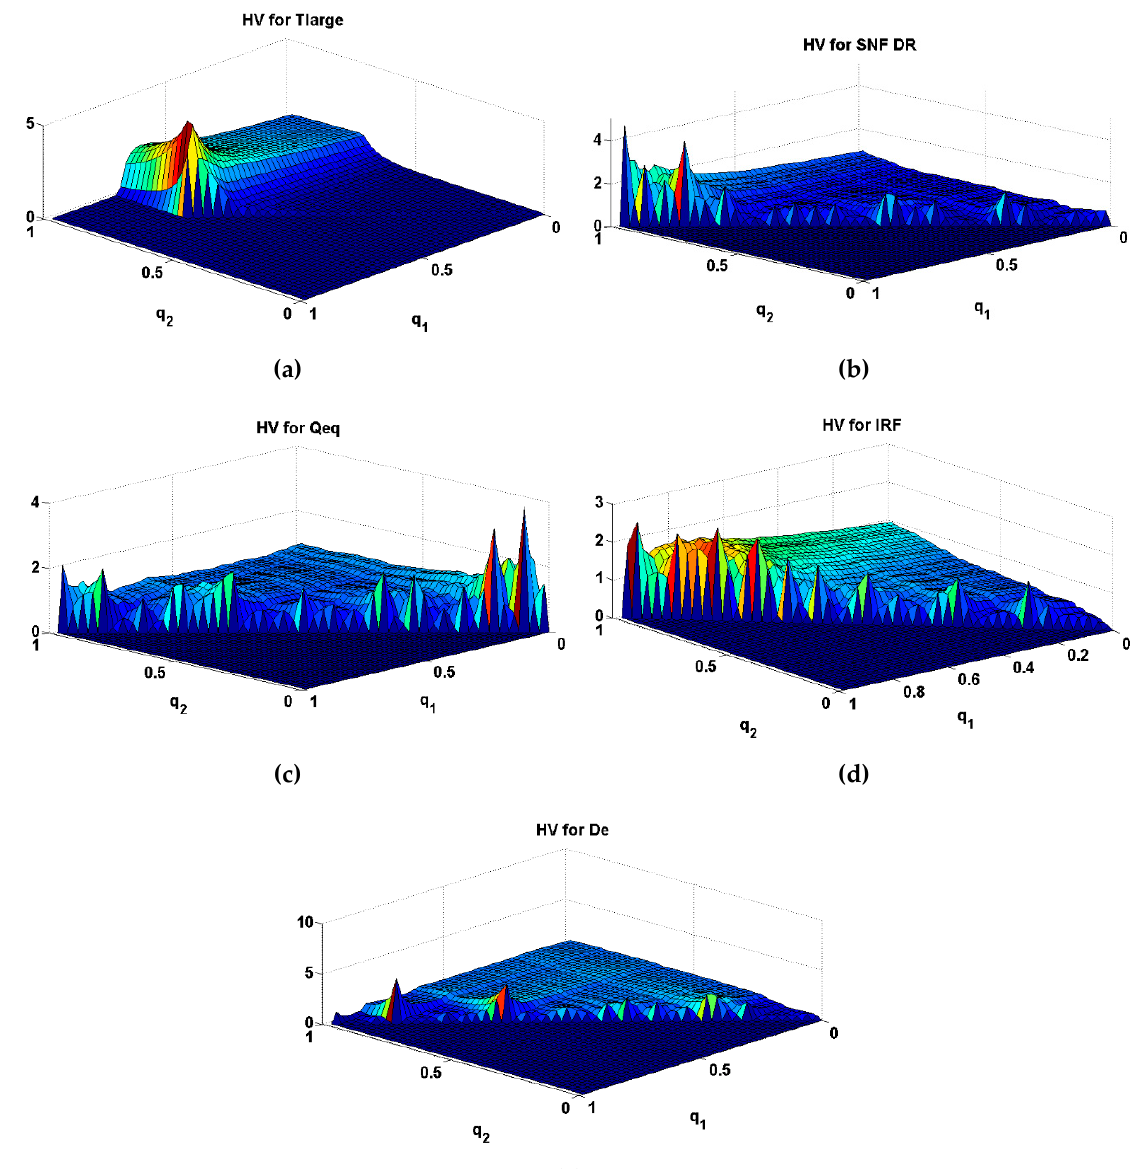
Figure 8. 3D plots of the revised variance ratio function (HV) for all parameters at t 5 = 5 × 10 4 years: